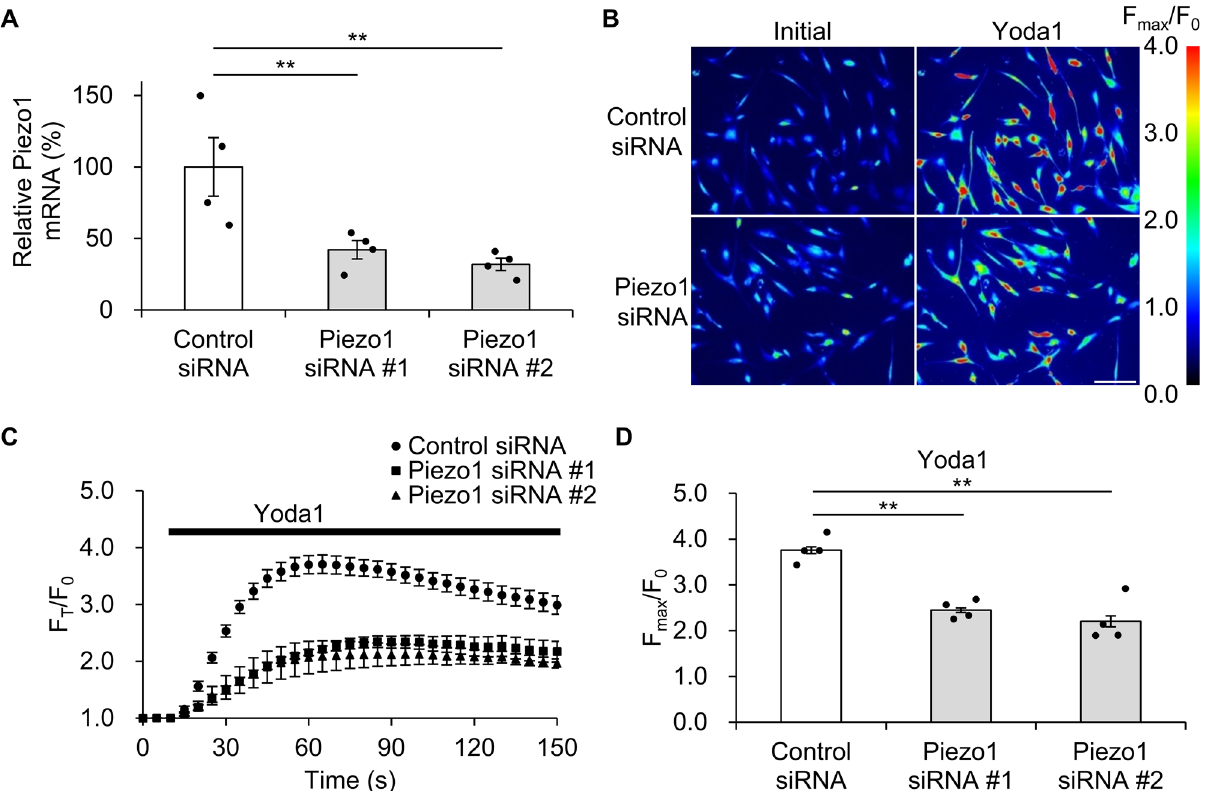
Figure 2. Efficacy of Piezo1 knockdown in human trabecular meshwork cells. ( A ) Relative Piezo1 mRNA levels in the human trabecular meshwork treated with control or Piezo1 siRNAs 24 h after transfection, as determined by qPCR. Data are normalized to GAPDH mRNA level. Data are presented as means ± SE (n = 4 samples of cDNA synthesized from RNA extracted from cells in 4 wells). ** p < 0.01, Dunnett’s test. ( B ) Representative images illustrating intracellular Ca 2+ changes in human trabecular meshwork cells transfected with control or Piezo1 siRNAs and stimulated with Piezo1 agonist Yoda1. Scale bar, 100 μm. ( C ) Time course of Yoda1-induced Ca 2+ changes in control or Piezo1 siRNA-transfected human trabecular meshwork cells. ( D ) Yoda1-evoked intracellular Ca 2+ elevation in human trabecular meshwork cells transfected with control or Piezo1 siRNAs. Data are expressed as the means ± SE (n = 4 experiments; ≥ 20 cells/experiment). ** p < 0.01, Dunnett’s